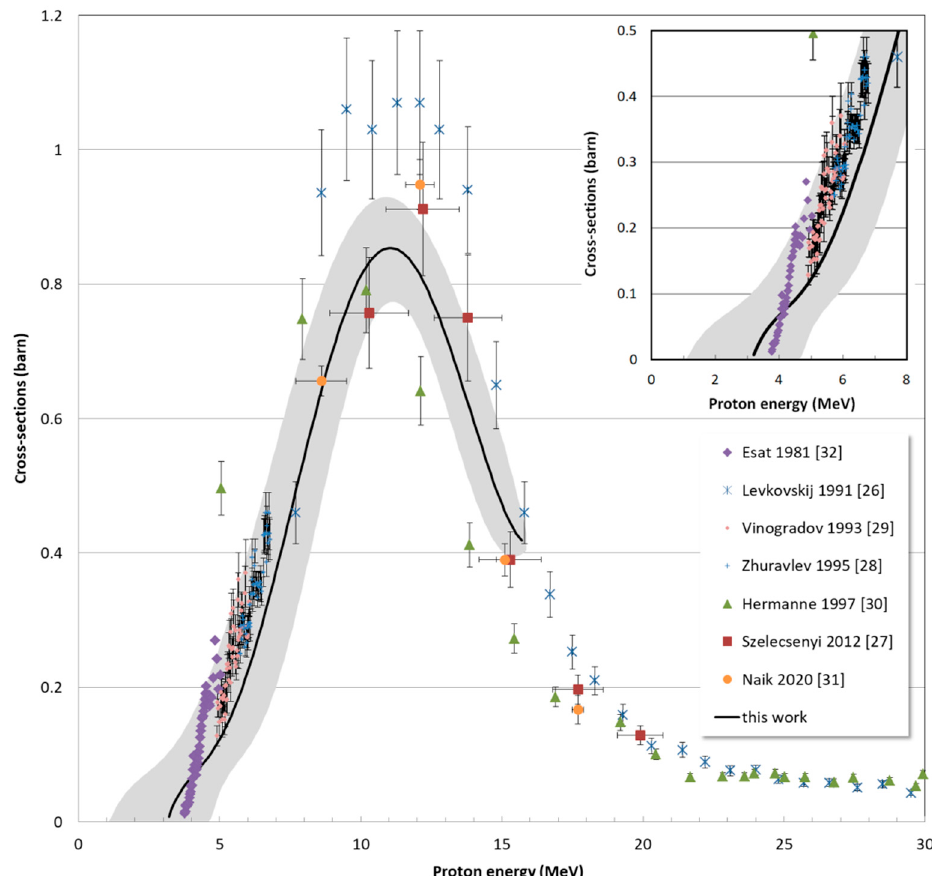
Figure 3. Experimentally deduced excitation function of the 68 Zn(p,n) 68 Ga nuclear reaction. The grey area represents the errors in the results presented as the black curve [26–32].